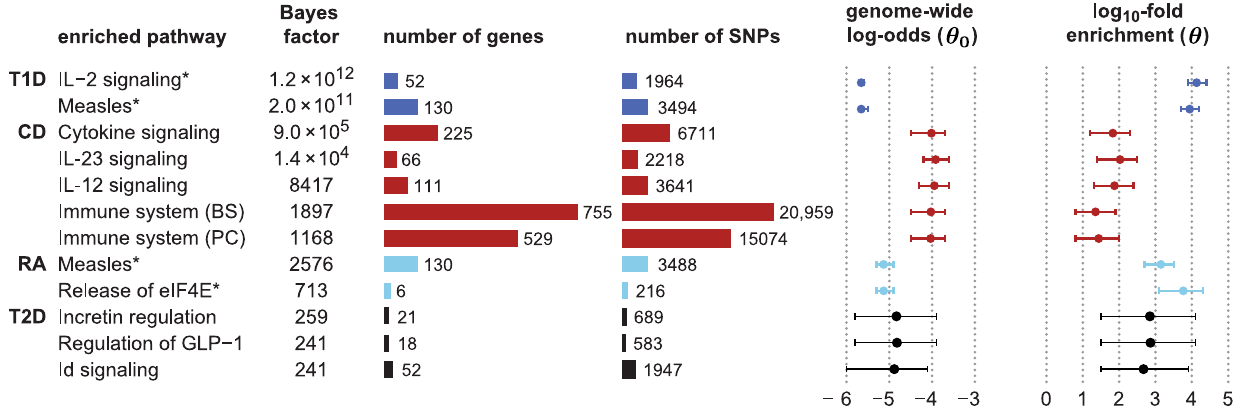
Figure 2. Top-ranked candidate pathways for enrichment of disease associations in CD, RA, T1D and T2D. Refer to Figure 1 for legend, abbreviations, and meaning of asterisk (*). Two right-most columns show posterior mean and 95% credible interval of genome-wide log-odds ( h 0 ) and log-fold enrichment ( h ) given that pathway is enriched ( h w 0 ). Note that enrichment level is defined on log-scale (eq. 2), so h w 0 indicates enrichment. Credible interval is smallest interval about mean that contains parameter with 95% posterior probability, calculated to nearest 0.1 using a numerical approximation. Database identifiers for pathways not previously mentioned: ‘‘IL23-mediated signaling events’’ (PID il23pathway, PC); ‘‘IL12- mediated signaling events’’ (PID il12_2pathway, PC); ‘‘Immune system’’ (Reactome 6900, BS 106386); ‘‘Release of eIF4E’’ (Reactome 6836, PC); ‘‘Synthesis, secretion, and inactivation of glucagon-like peptide-1’’ (Reactome 24019, PC); ‘‘Id signaling pathway’’ (WikiPathways WP53 [166], BS 198871). See Figure S1 for more gene set enrichment